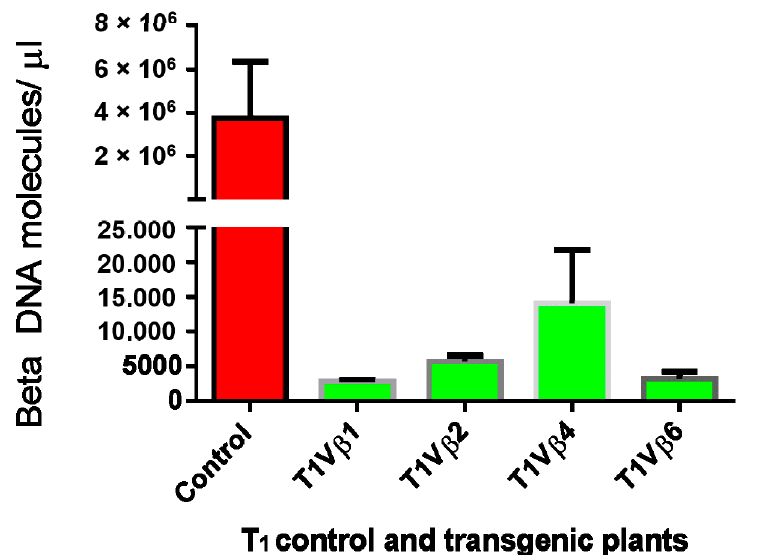
Figure 4. Quantitative polymerase chain reaction amplification detection of CLCuMB molecules/µL in total DNA purified from the T 1 transgenic cotton plants, T1V β 1, T1V β 2, T1V β 4, T1V β 6, compared to a non-transgenic, positive control cotton plant.